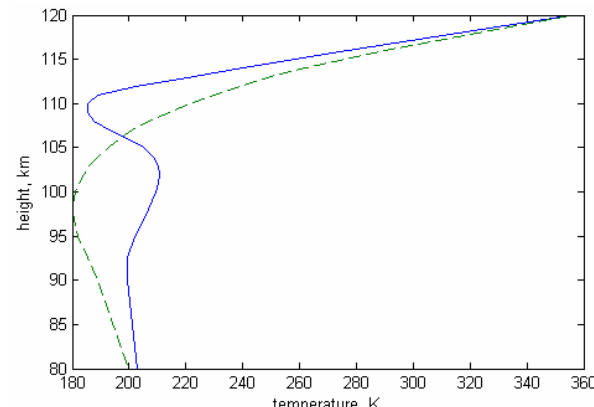
Figure 3. Height profiles of the neutral temperature: the background profile given by the MSIS-E-90 model (dashed curve) and the profile calculated by the model (solid curve).